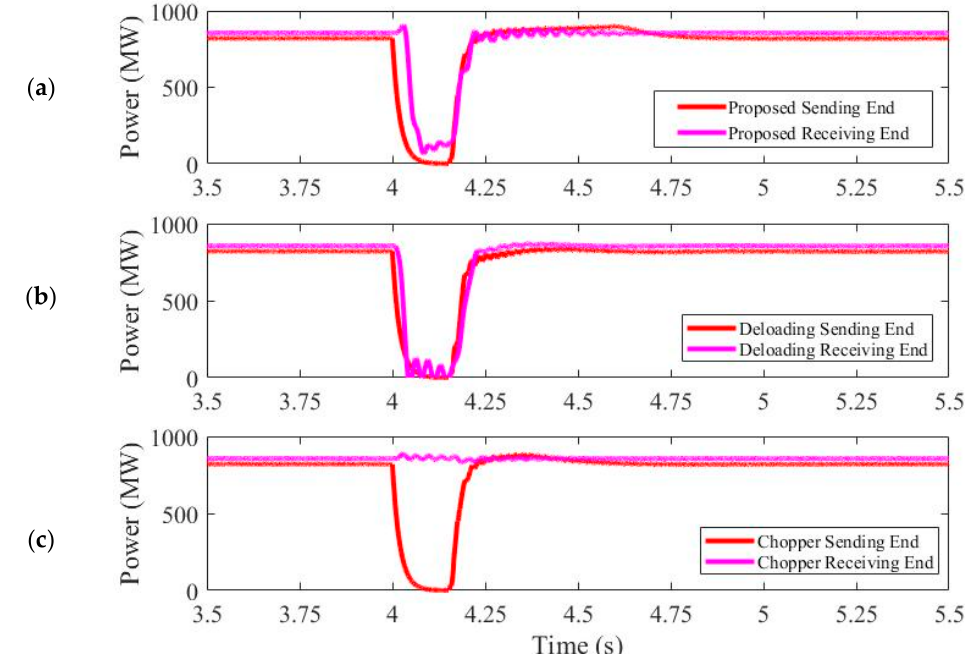
Figure 9. Simulation results of the on-shore fault scenario with a 0.001 Ω fault resistance. ( a ) On-shore and off-shore power with the proposed control strategy case. ( b ) On-shore and off-shore power with the deloading control strategy case. ( c ) On-shore and off-shore power with the DC chopper strategy case.